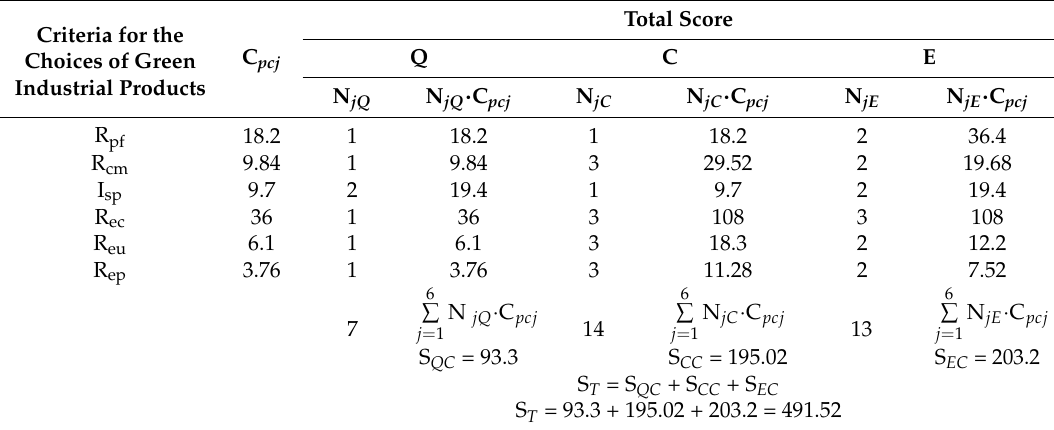
Table 7. Determination of the performance indicators total score based on the weighting coefficients of the criteria C pcj and the scores assigned to the indicators N jQ , N jC , N jE . Criteria for the Choices of